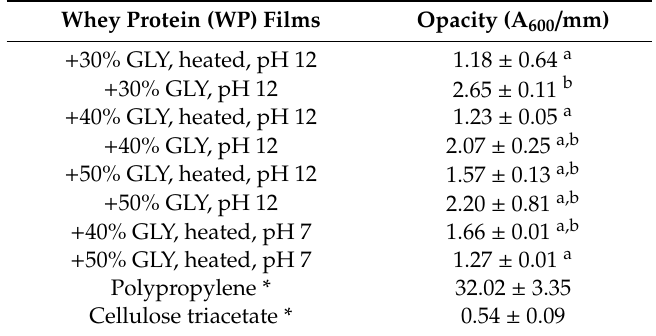
Table 6. Opacity of whey protein (WP)-based films obtained under di ff erent experimental conditions. Whey Protein (WP)